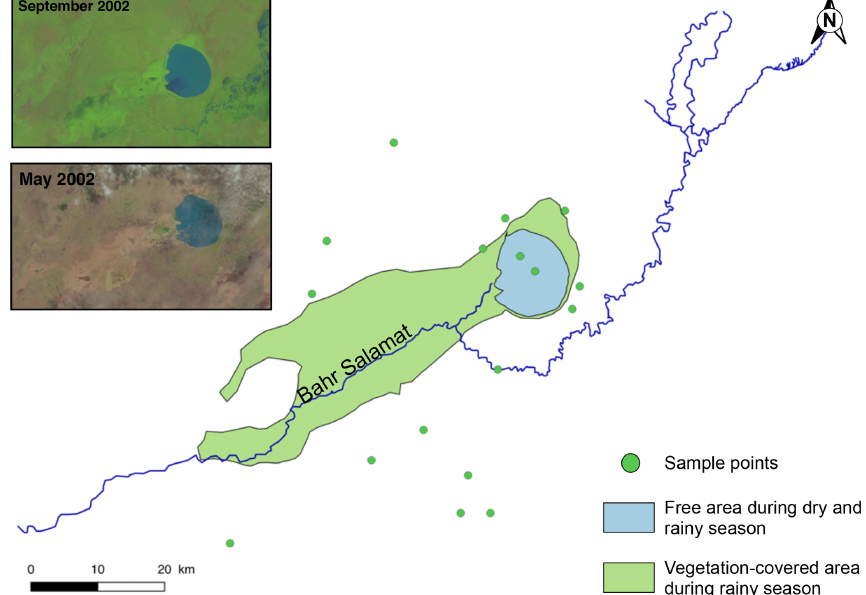
Figure 2. Landsat 7 pictures of Iro Lake during the wet season (September) and at the end of the dry season (May). The states of the lake are represented in blue for open water and in green for vegetation covering the flood plain during the rainy season. Only a portion of the Bahr Salamat river feeds the lake. Green dots represent the sampled water during April